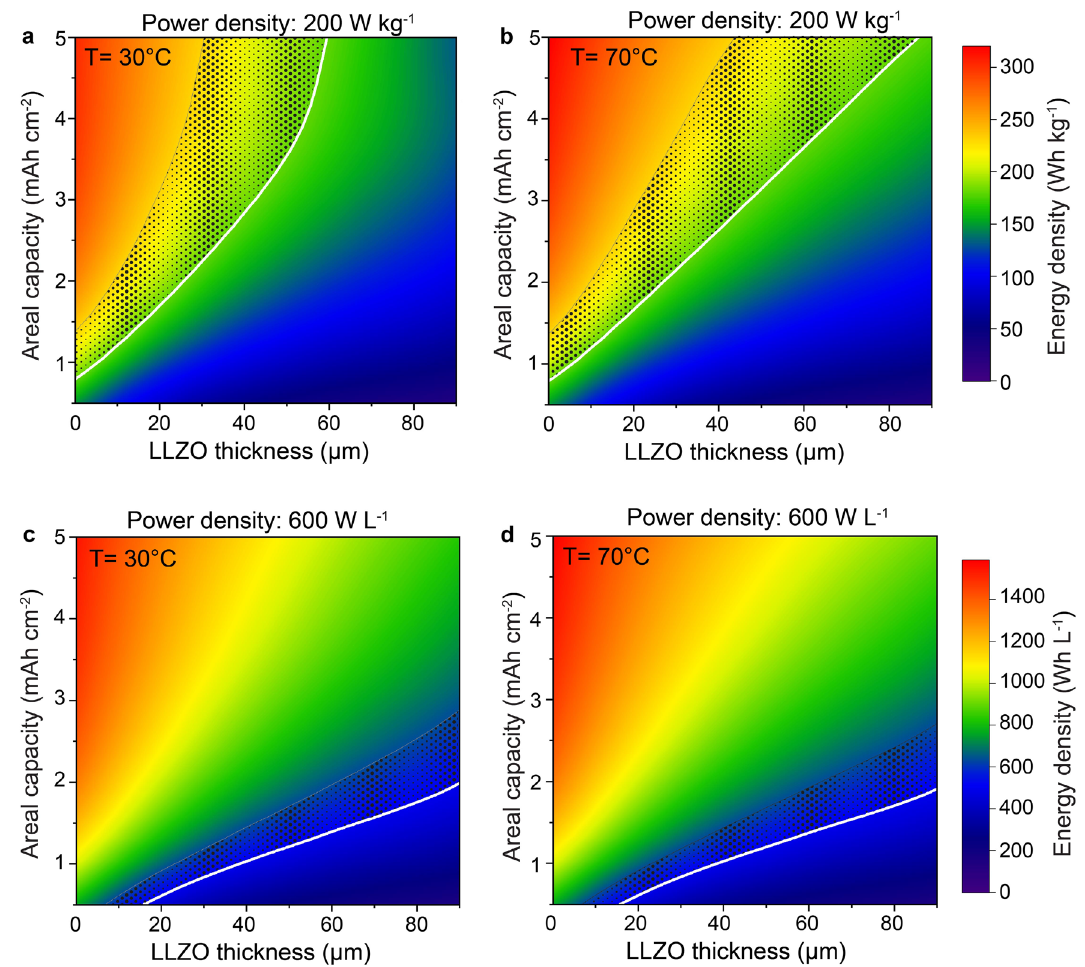
Figure 3. Simulated gravimetric ( a , b ) and volumetric ( c , d ) energy densities of Li/LLZO/LCO all-solid-state battery vs. cathode areal capacity and LLZO thickness plotted at power densities of 200 W kg −1 and 600 W L −1 and temperatures of 30 °C and 70 °C. The composition of LCO cathode is constant (70 vol.% of LCO and 30 vol.% of LLZO). The areal capacity (thickness) of the Li metal anode corresponds to 20% of the cathode areal capacity. The gravimetric and volumetric energy densities of Li-free/LLZO/LCO all-solid-state battery (so-called Li-free configuration), are shown in Supplementary Fig. S29 for